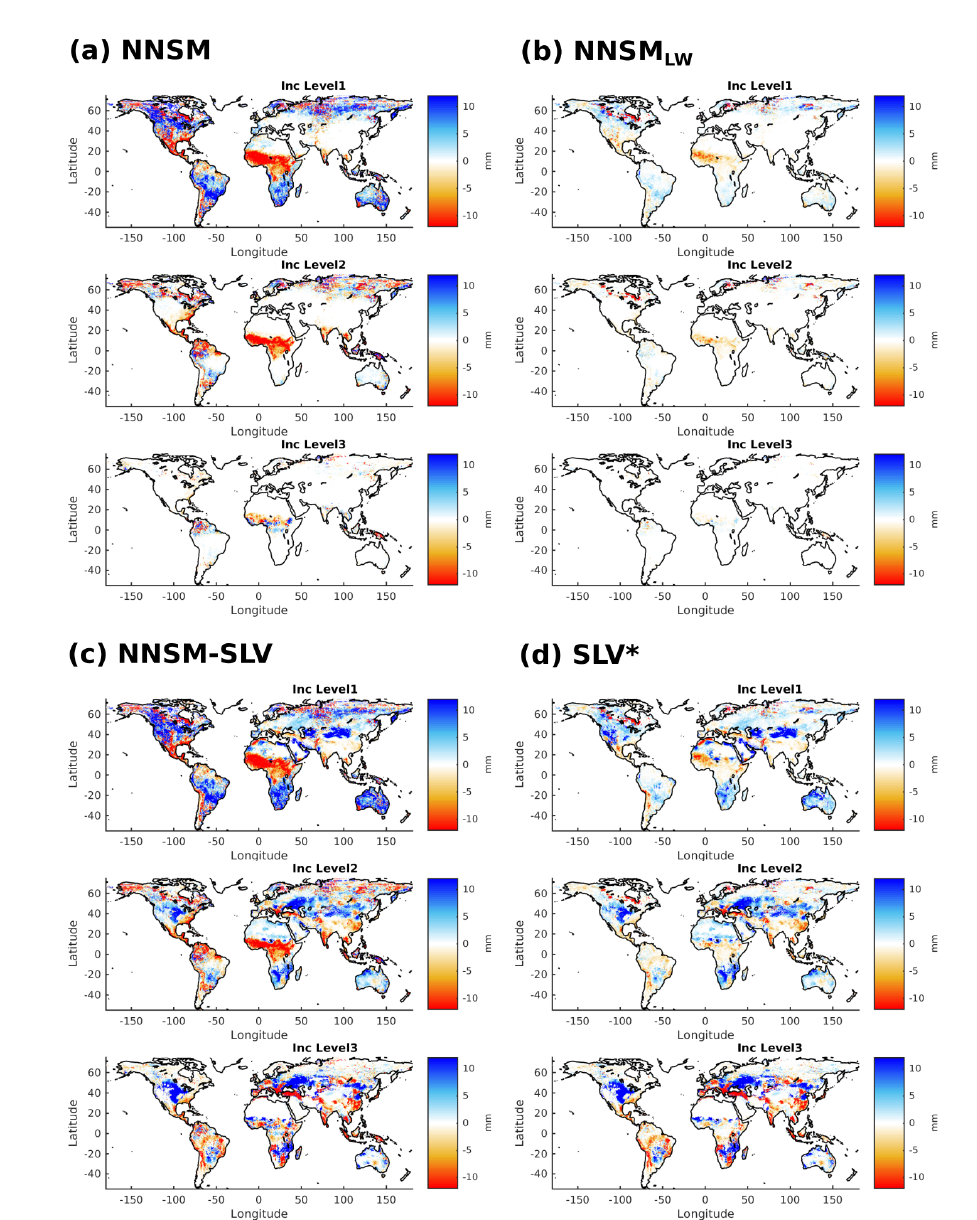
Figure 5. Increments sum in mm for the period July-September for experiments NNSM and NNSM LW (panels a and b ) and for experiments NNSM-SLV and SLV* (panels c and d